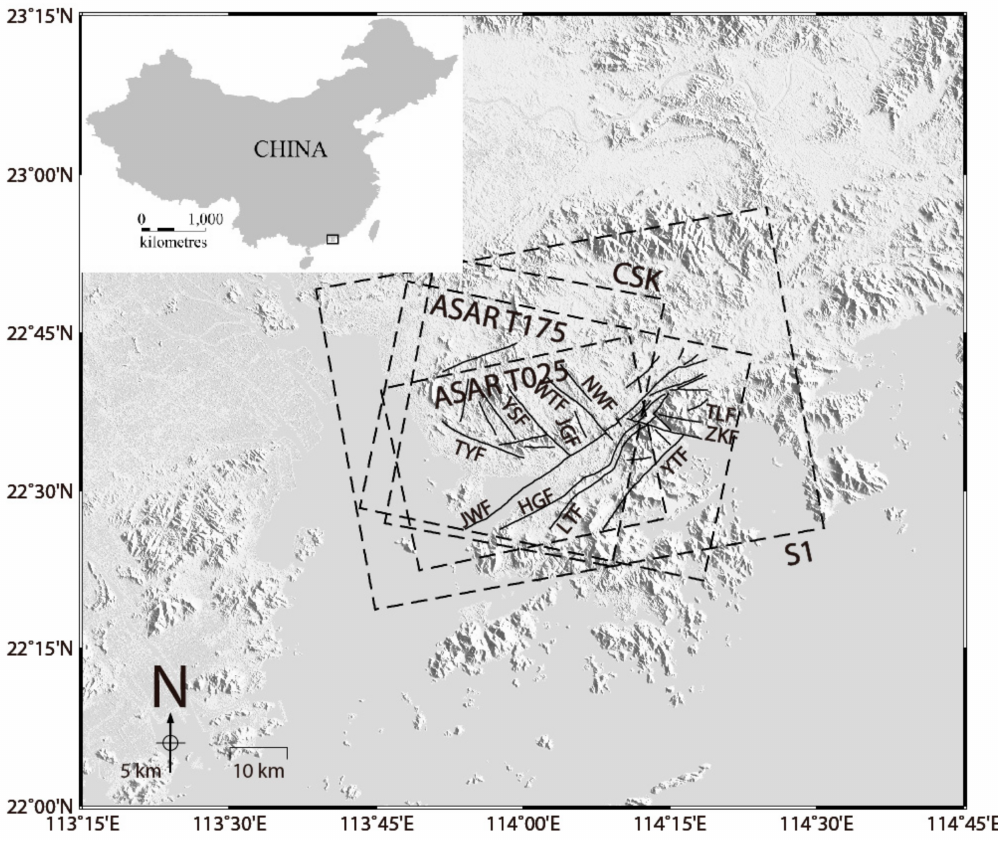
Figure 2. Study area and major faults. Footprints of ASAR T175, ASAR T025, CSK and S1 images are outlined in dashed lines. The NE trending faults in our study area are Jiuweiling fault (JWF), Henggang-Luohu fault (HGF), Liantang fault (LTF), and Yantian fault (YTF). The NW trending faults in our study area are Tongluojing fault (TLF), Zhengkeng fault (ZKF), Niuweiling fault (NWF), Wentang-guanlan fault (WTF), Jigongshan fault (JGF), Yangtaishan fault (YSF), and Taoyuan fault (TYF)